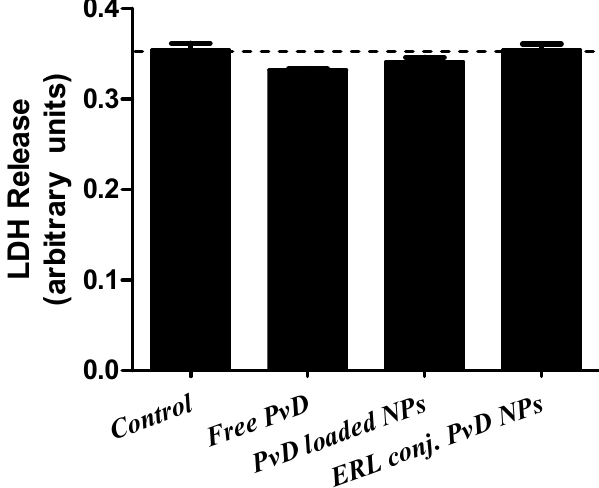
Figure 15. Lactate dehydrogenase (LDH) assay, using free PvD, ERL conjugated empty BSA NPs, ERL conjugated PvD-loaded BSA NPs. Results are expressed as mean ± SEM for three different experiments.